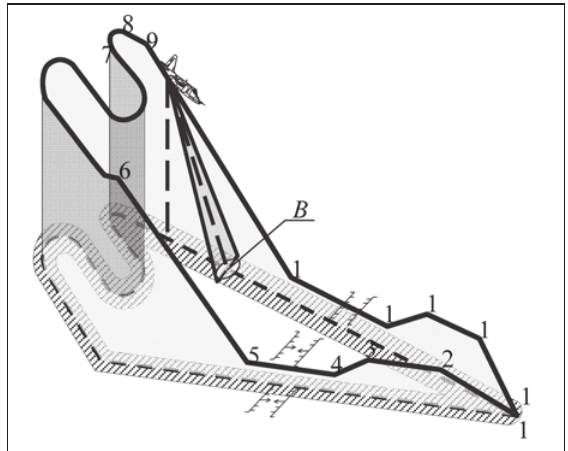
Fig. 2. Space flight path